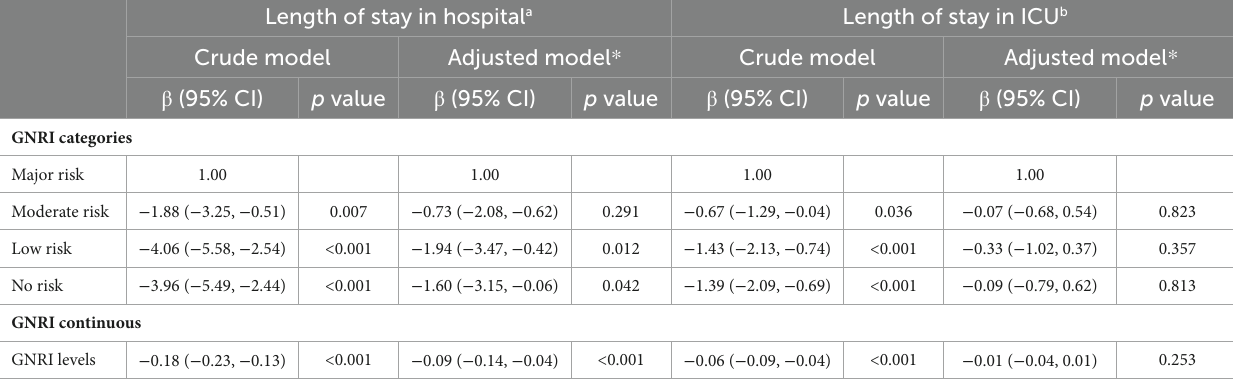
TABLE 4 Multivariable linear regression of the association between GNRI and length of